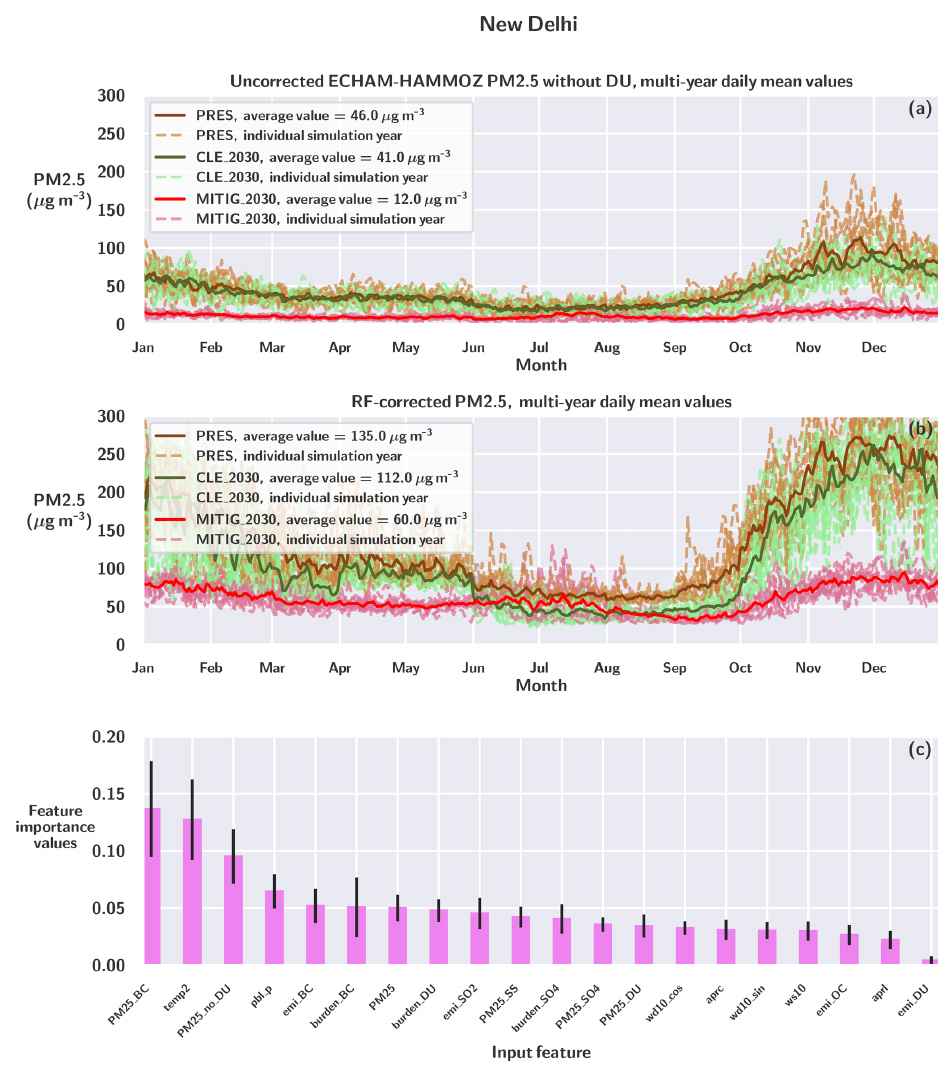
Figure 2. (a) The uncorrected ECHAM-HAMMOZ PM 2 . 5 concentrations (excluding dust) for PRES, CLE_2030 and MITIG_2030 simula- tions as multi-year daily average values for each scenario. Individual years are marked with dashed curves, and the multi-year daily average values are shown with solid, colored lines. (b) The RF-corrected concentrations for PRES, CLE_2030 and MITIG_2030 simulations as multi-year daily average PM 2 . 5 values for each scenario. The dashed lines represent the prediction for each individual year, and the thick solid lines are the multi-year daily averages. (c) The average normalized feature importance values for the input features are represented with pink bars. The black whiskers show the standard deviation of individual RF model importance